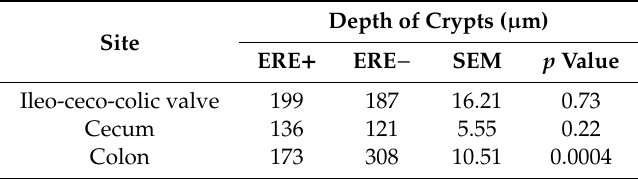
Table 1. Mean crypt depths in three regions of the rabbit intestine. Values shown are the mean of 10 crypts from the 6 animals per treatment; ERE + (infected) versus ERE −